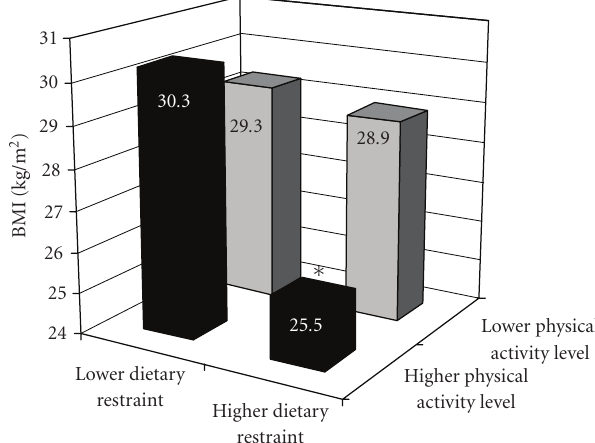
Figure 1: Body mass index in the group of postmenopausal women is separated on the basis of dietary restraint and physical activity participation. Lower and higher physical activity participation are presented in grey and in black respectively. ∗ indicats a significant di ff erence in women with lower dietary restraint and higher physical activity participation. For lower physical activity participation and lower dietary restraint, n = 37, and mean BMI = 29.3 ± 1.0kg/m 2 ; for lower physical activity participation and higher dietary restraint n = 27, and mean BMI = 28.9 ± 0.9 kg/m 2 ; for a higher physical activity participation and lower dietary restrain, n = 23, and mean BMI = 30.3 ± 1.7 kg/m 2 and for a higher physical activity participation and higher dietary restraint, n = 26, and mean BMI = 25.5 ± 0.5 kg/m 2